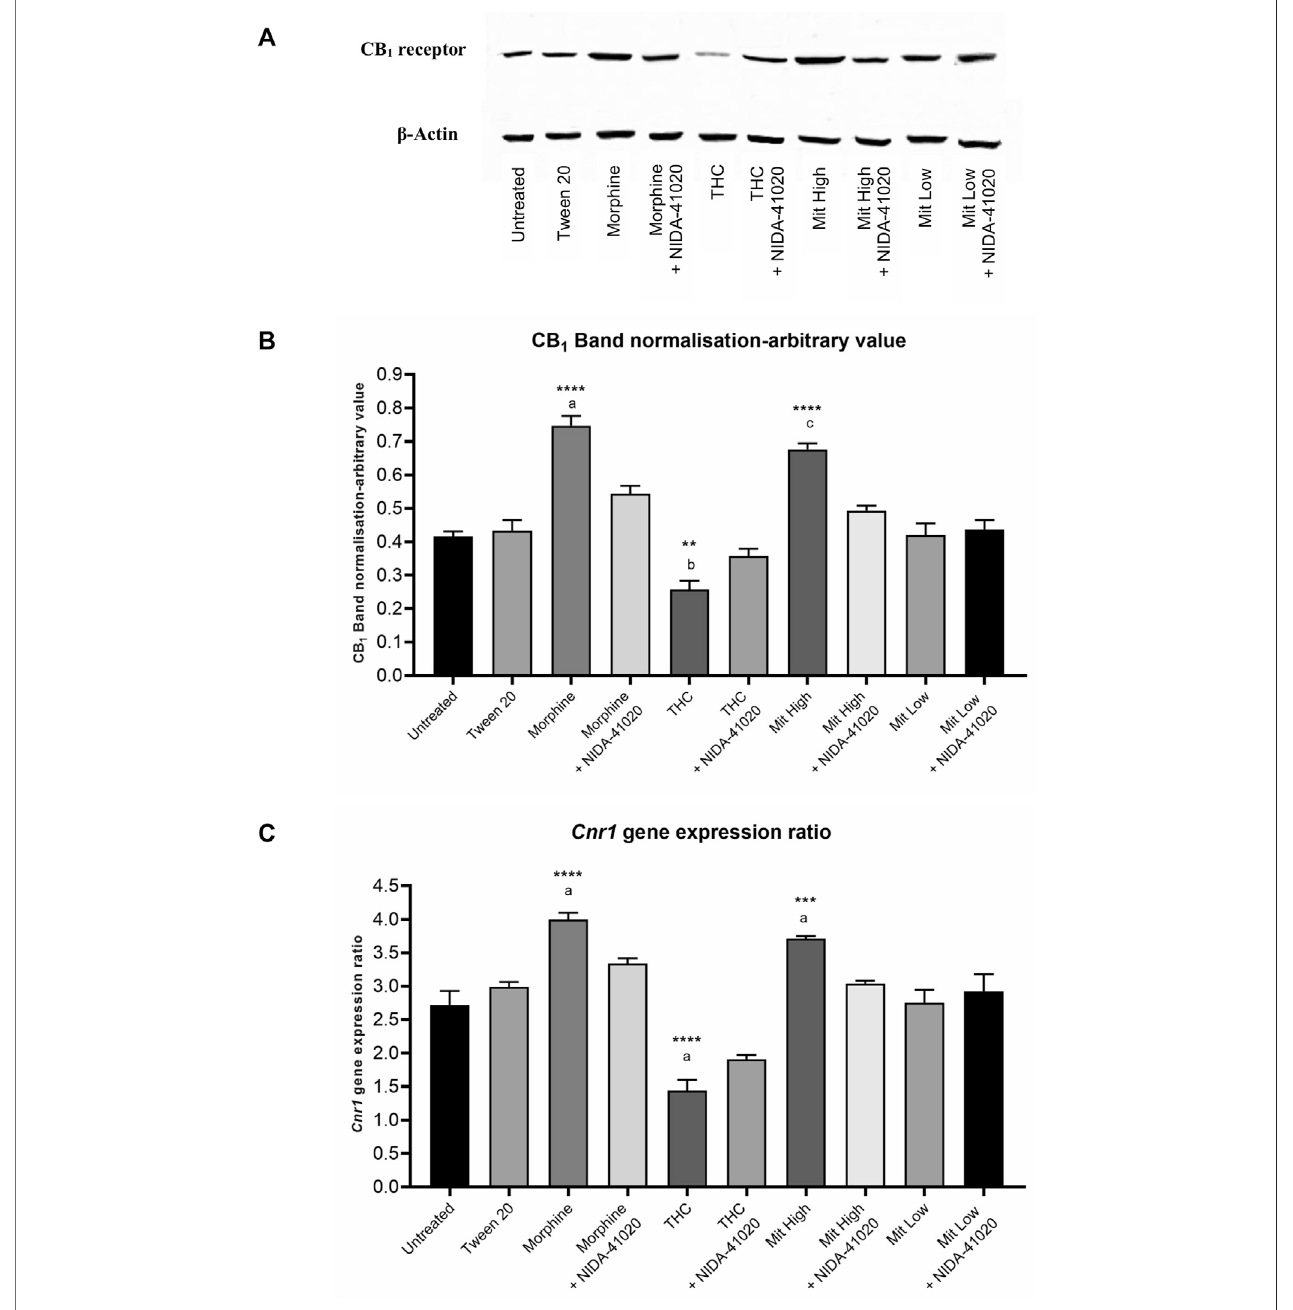
FIGURE8| CB 1 receptor (A,B) proteinand (C) genelevelsinmicebrainmesolimbicareaafter28daysofdrugintervention.Dataareshownasthemean+SEMof three biologicalreplicatesper group.The CB 1 receptor valueshave beennormalizedto β -actin controls.Datarevealedthathigh-dose mitragynine and morphine groups signi fi cantly increased, whereas THC decreased; CB 1 receptor expression in the brain mesolimbic area vs controls and low-dose mitragynine group. NIDA-41020 reversedthedrug-inducedCB 1 receptoralteration.*** p < 0.001,**** p < 0.0001vsTween20;a: p < 0.05vsdrug+NIDA-41020groups(one-wayANOVAfollowed by post-hoc Tukey